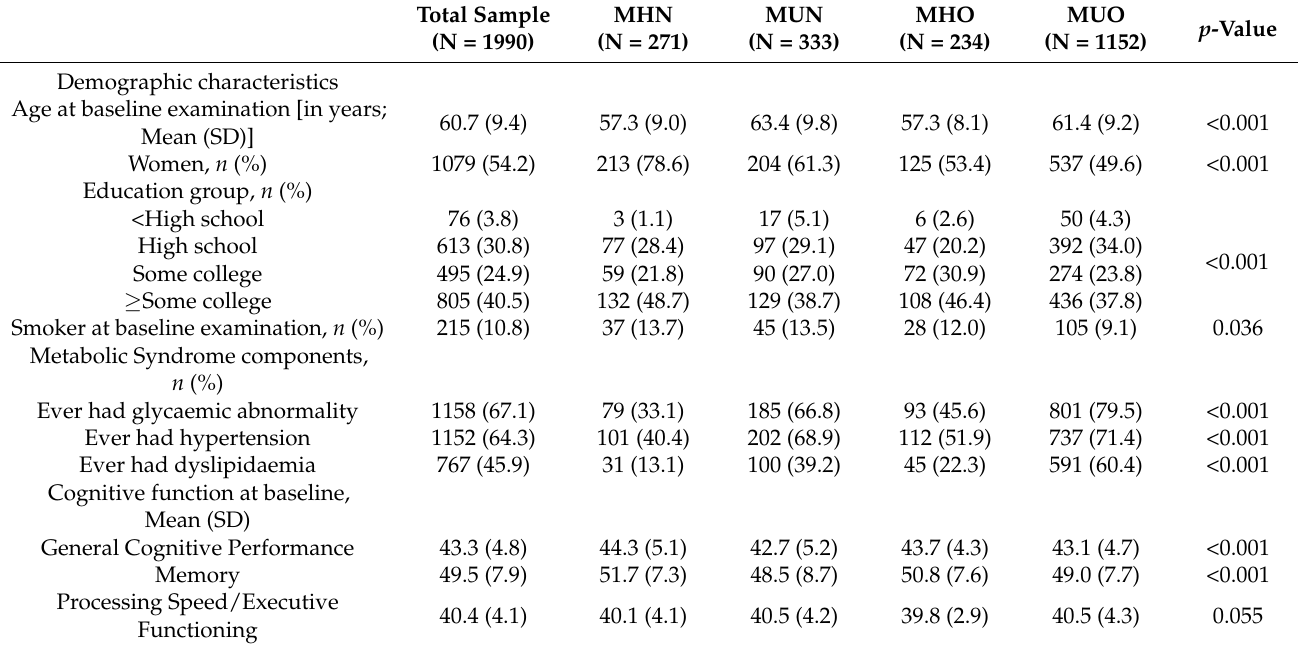
Table 1. Baseline characteristics of the study sample according to the obesity and metabolic health status. Total Sample